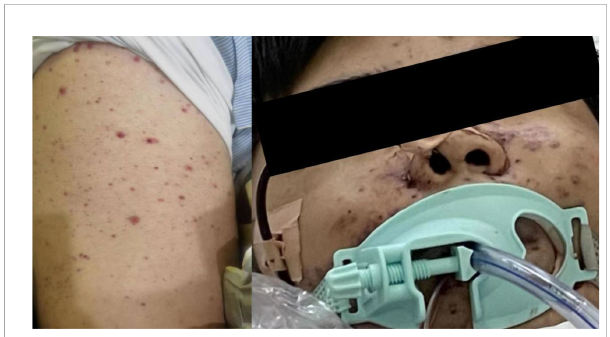
FIGURE 1 Representative clinical images from presentation showing a diffuse rash at different stages of development, including papules, vesicles, pustules, and crusted